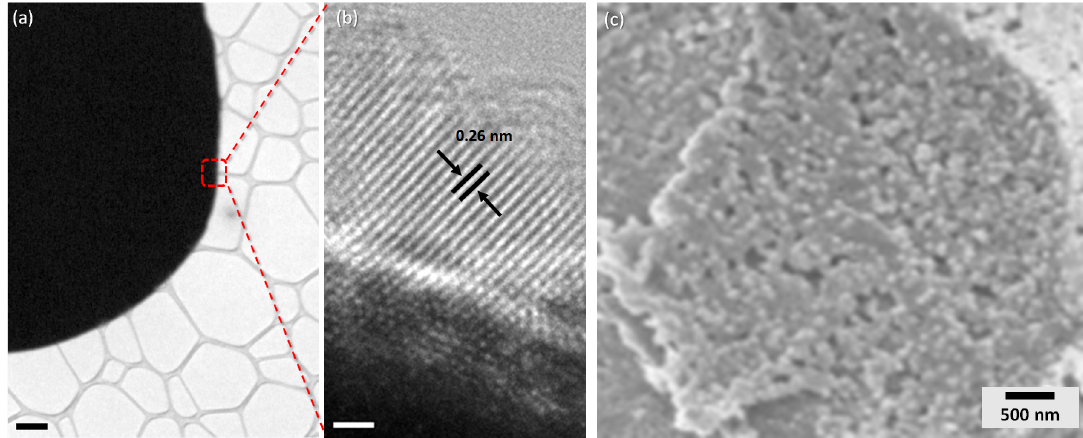
Figure 4. ( a ) Transmission electron microscopy (TEM) images of a single ZnO microsphere and ( b ) high magnification of the edge of the microsphere showing the lattice fringes. ( c ) High-magnification SEM images of a zinc oxide microsphere shell showing the porous nanosized zinc oxide particles. Scale bars: ( a ) 1 µ m; and ( b ) 1